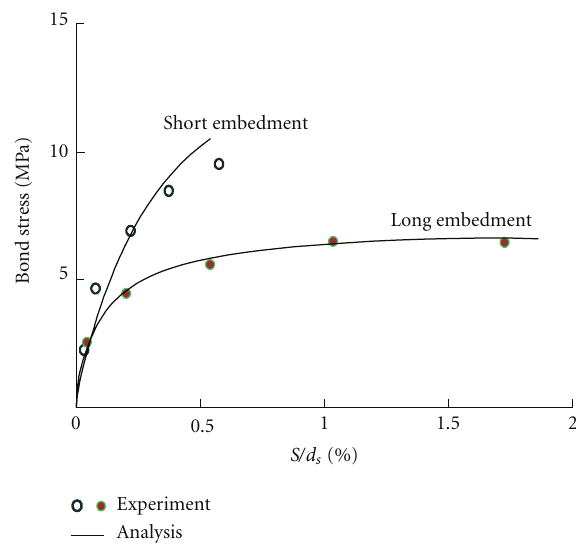
Figure 3: Bond stress-slip relationships of short embedment and long